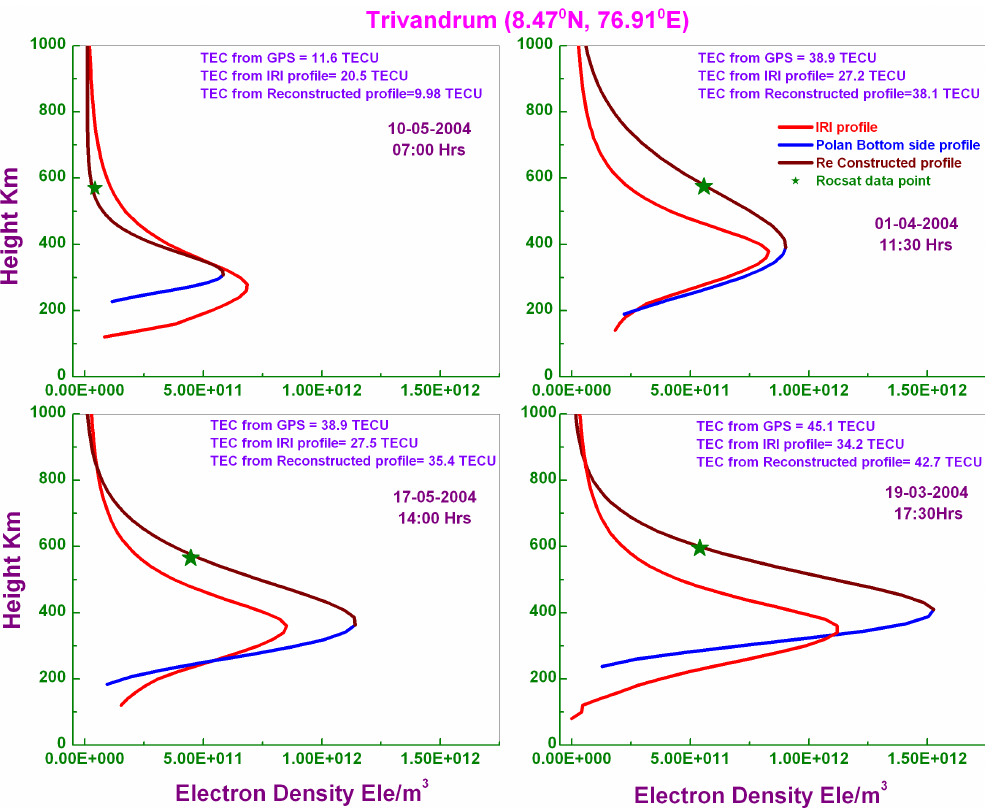
Fig. 2. Typical examples of vertical electron density profiles reconstructed over an equatorial station Trivandrum during four different time intervals. IRI model derived profiles (red lines) are also plotted for